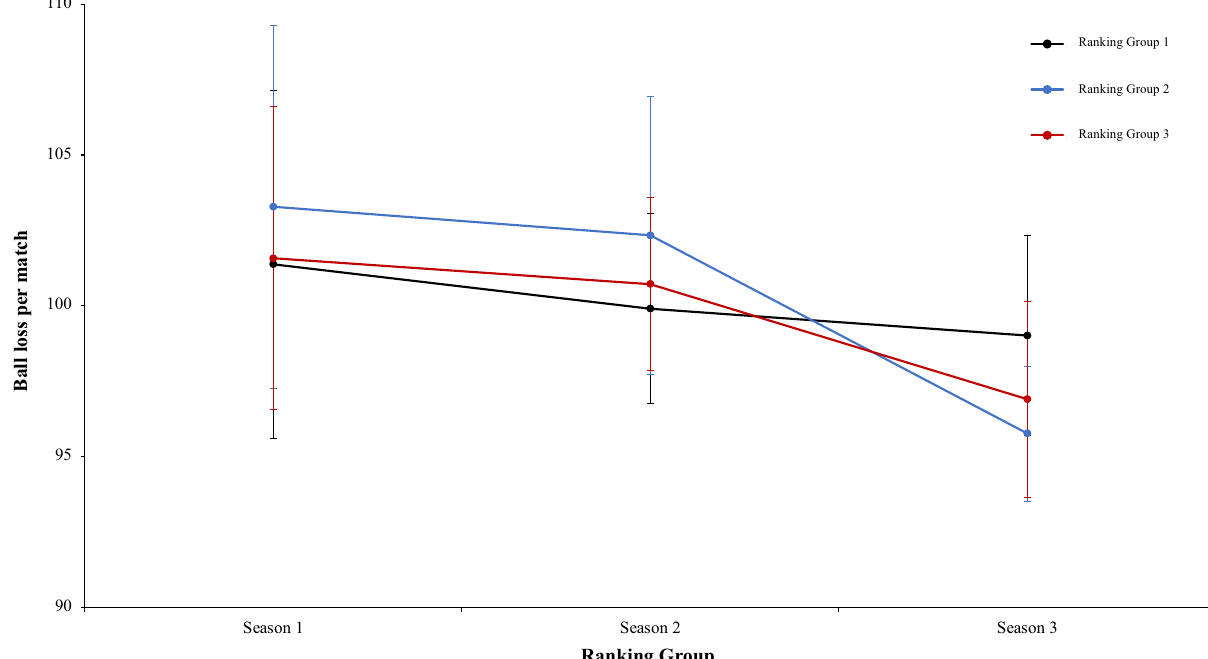
Figure 16. Technical performance. Mean ball loss per match (± SE) as a funtion of Ranking and Season Condition.